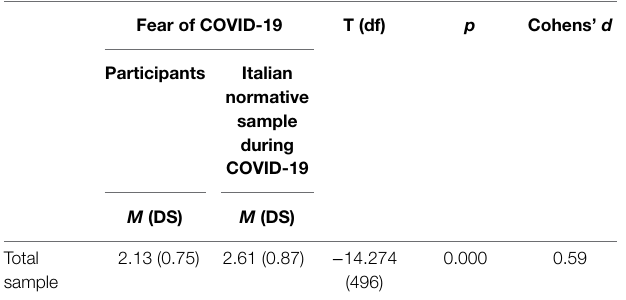
TABLE 1 | Sociodemographic characteristics of the participants ( N = 500). Category